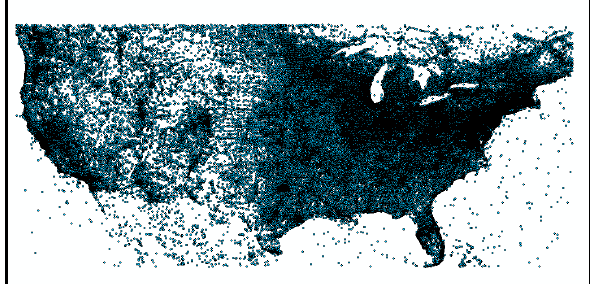
Figure 2. Geo-articles from Wikipedia knowledgebase created from October 2014 database